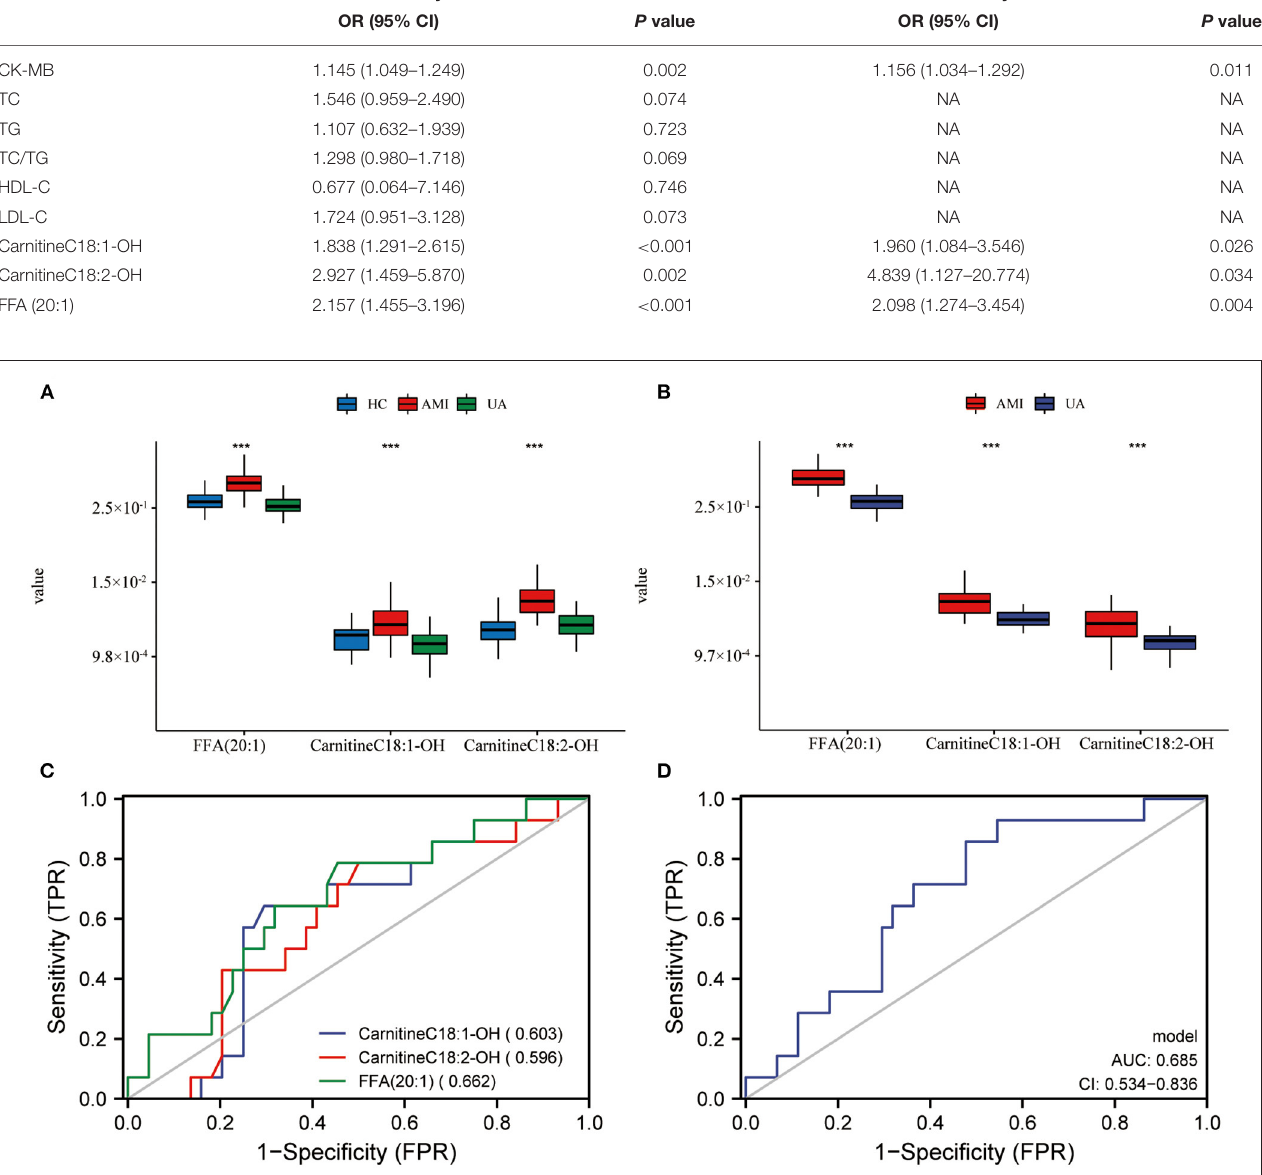
FIGURE 7 | Prognostic evaluation of lipid biomarkers and expression in AMI patients. Expression level of lipid biomarkers in discovery set (A) and validation set (B) . The prognostic evaluation of lipid biomarkers (C) and model (D) in whole set. *** P < 0.001.